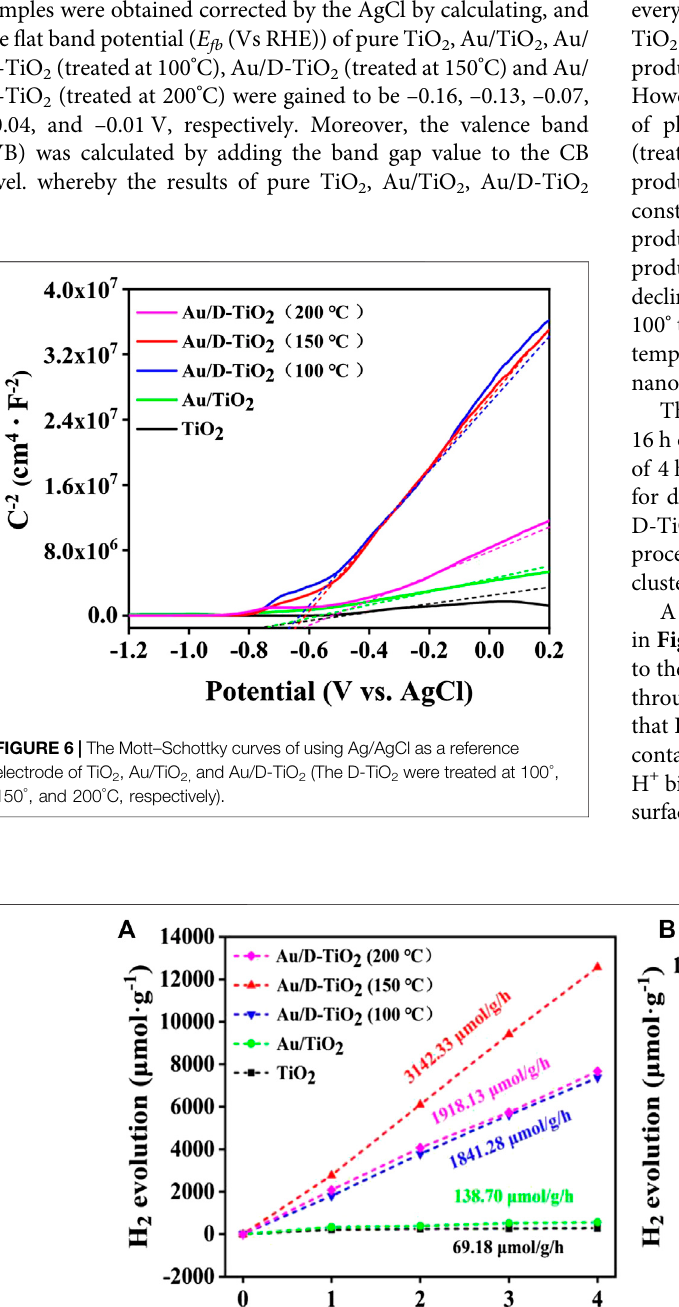
Frontiers in Physics |